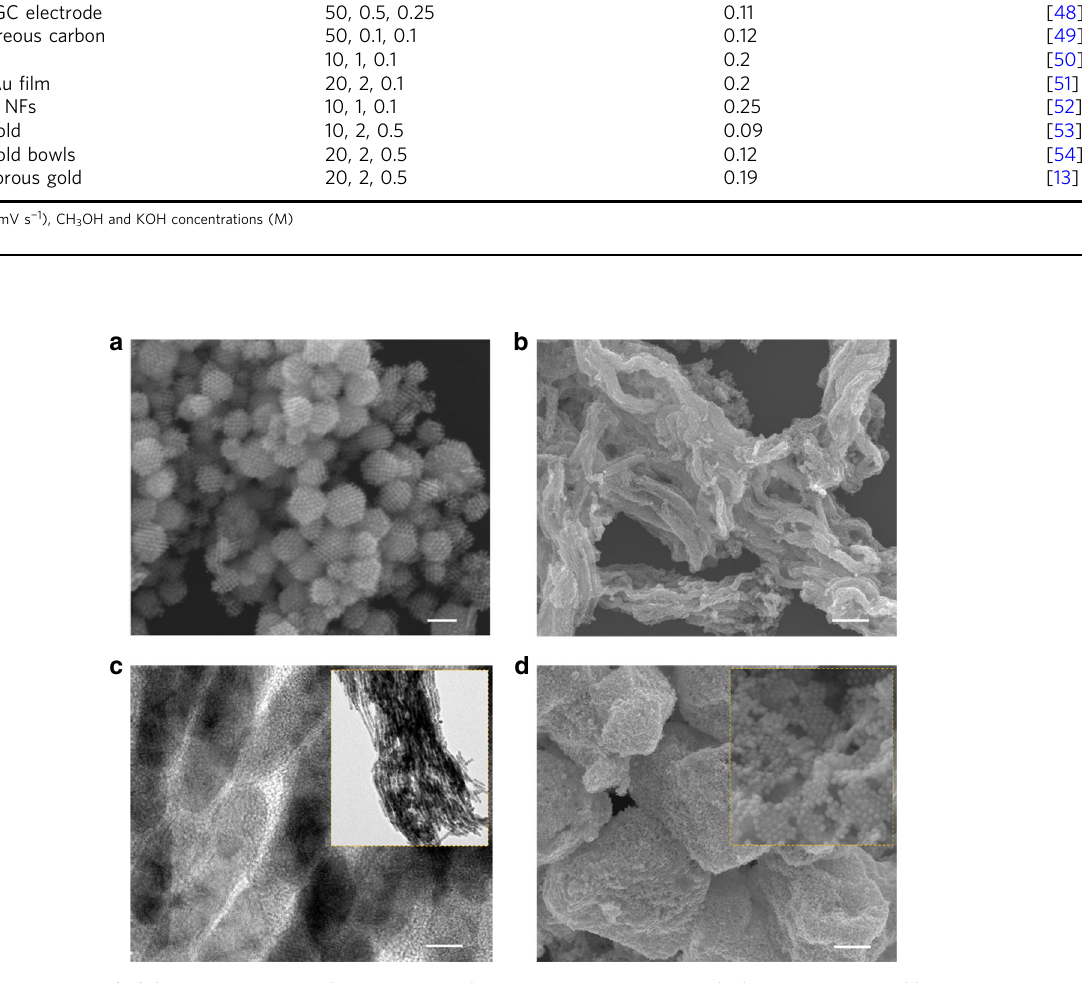
Fig. 6 The effectiveness proof of the SLS strategy in other systems. a The 3D mesoporous Pt networked structure prepared by using a KIT-6 template. b , c Ag nanowires obtained via an SBA-15 template. d The 3D mesoporous Au nanoparticle superlattice prepared using EP-FDU-12 as the template. The insets in c and d are the magni fi ed images of corresponding structures obtained from the current soft-enveloped SLS interface reaction strategy. The scale bars in a , b , c , and d are 100, 500, 5, and 500